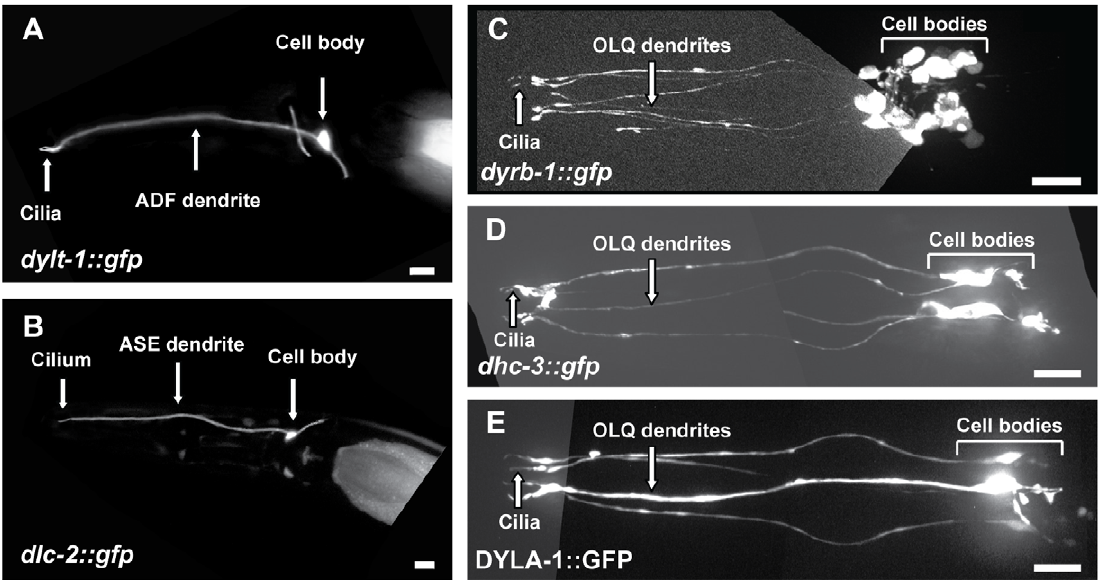
Figure 1. Expression patterns of candidate IFT-dynein genes. (A) A transcriptional dylt-1::gfp construct is expressed in the double-ciliated amphid neuron ADF. (B) A transcriptional dlc-2::gfp construct is expressed in the single-ciliated amphid neuron ASE. (C) A transcriptional dyrb-1::gfp construct is expressed in the ciliated neurons of the quadrant sensilla (OLQ neurons), and in other ciliated sensory neurons. (D) A transcriptional dhc- 3::gfp construct is expressed in the OLQ neurons. (E) A translational DYLA-1::GFP construct is expressed in the OLQ neurons. In all the panels, Anterior is to the left and the horizontal bars represent 10 m m.